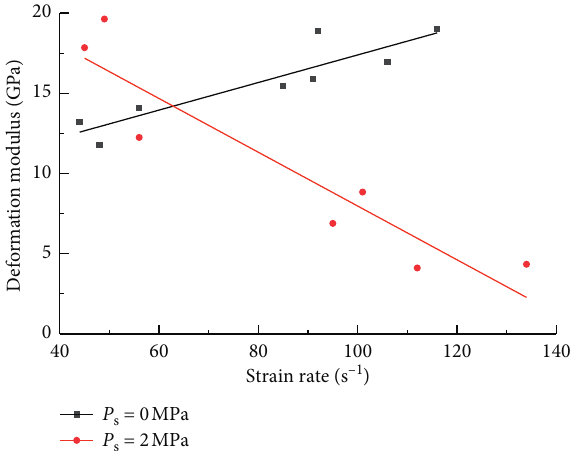
Figure 7: Relationship between dynamic deformation modulus and average strain